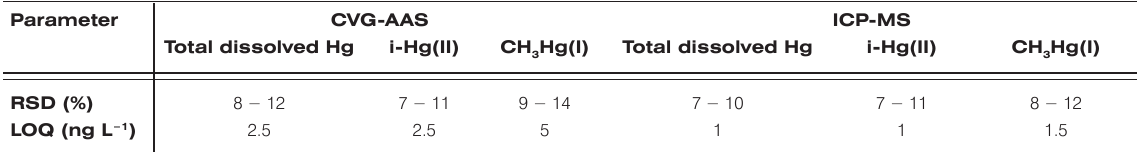
Table 3. Figures of